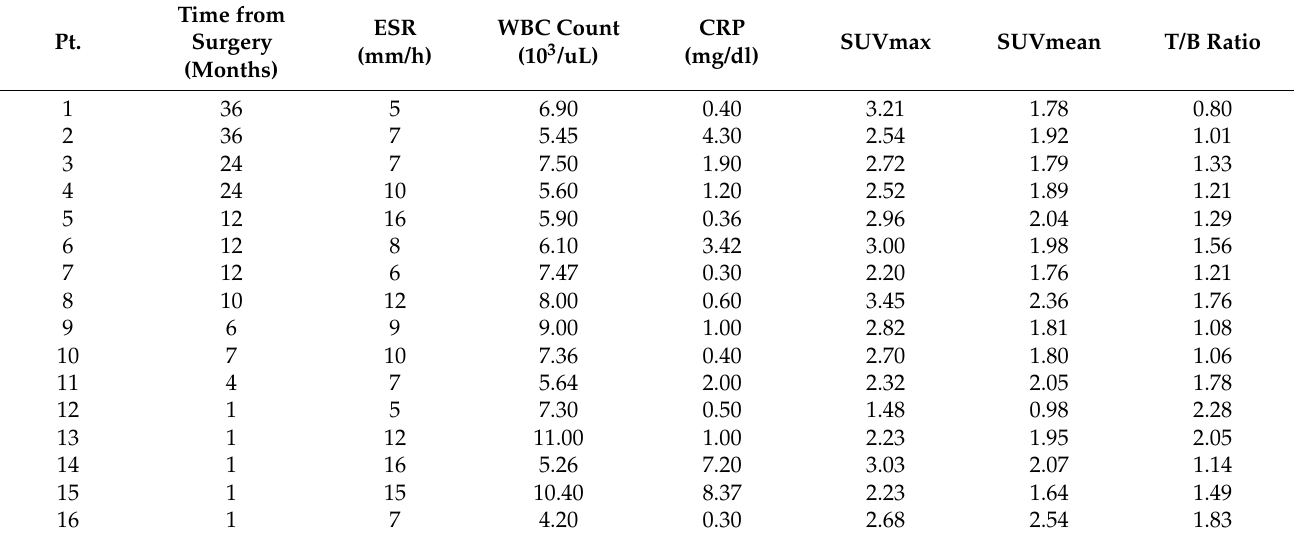
Table 2. Patient’s